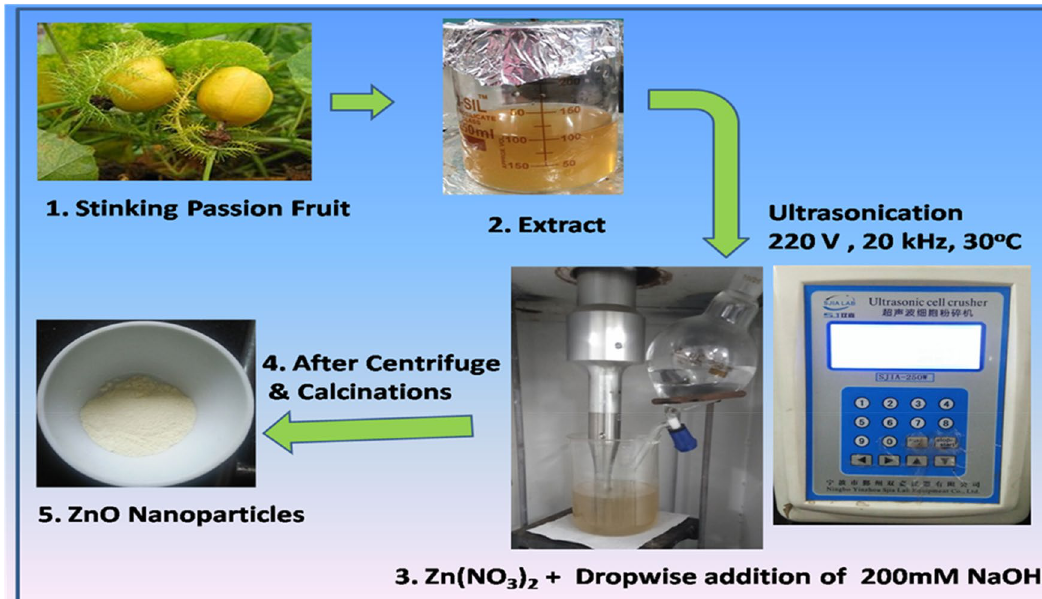
Fig. 1 Schematic representation ofthe synthesis of ZnO